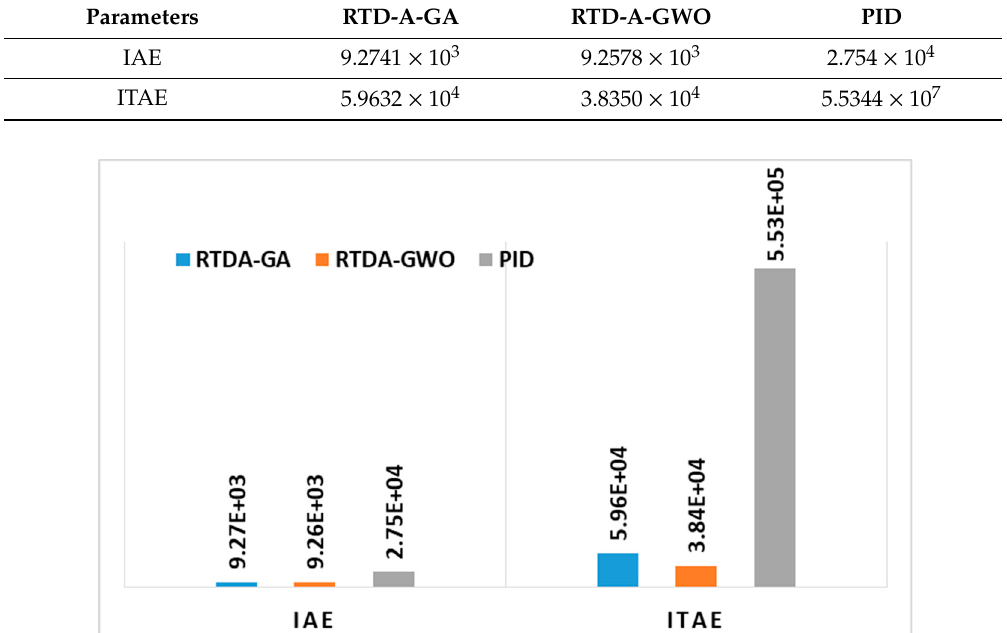
Figure 17. Case-2: Performance comparison chart between the gain scheduled RTD-A and PID.